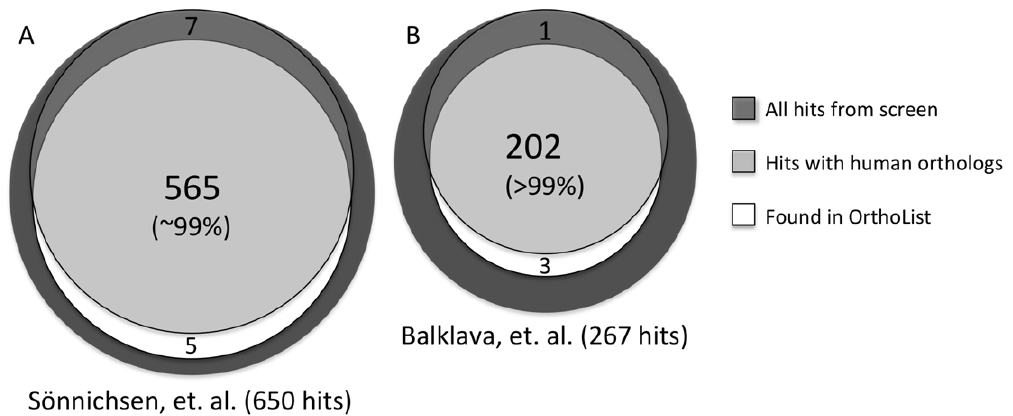
Figure 4. OrthoList coverage of hits from genome-wide RNAi screens. Venn diagrams analyzing hits obtained from RNAi screens examining (A) cell division [43] and (B) endocytic/secretory trafficking [44]. For each screen the overlap between OrthoList and the orthologous subset of hits is shown (percentage refers to how well covered by OrthoList this conserved subset is). Orthology assignments for hits missing from OrthoList (shown above overlap) and those found in OrthoList that were not called homologs in the original publications (shown below overlap) were confirmed by TreeFam and/or RBH (see Materials and Methods). Source data for these diagrams can be found in Tables S6 and S8.